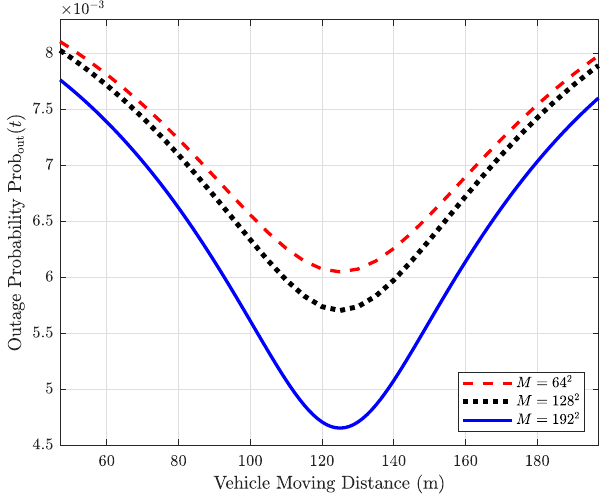
Figure 8. Outage probability for one vehicle pass. D MR ( t ) is [ − 125 + vt ,15,20 ] T